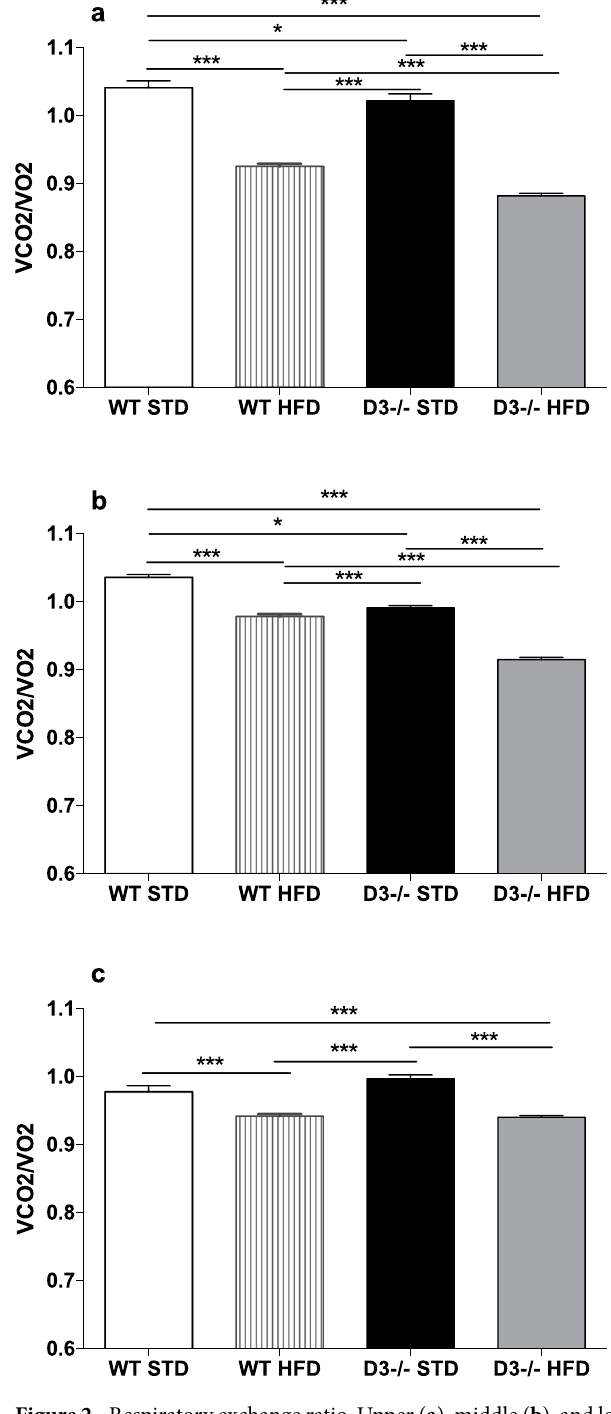
Figure 2. Respiratory exchange ratio. Upper ( a ), middle ( b ), and lower ( c ) panels are referring to juvenile (D3 − / − , n = 12; WT, n = 10), adult (D3 − / − , n = 11; WT, n = 7) and aged (D3 − / − , n = 8; WT, n = 9) mice, respectively. RER ( V CO 2 / V O 2 ) as the extent of lipid vs. carbohydrate oxidation in STD or HFD feeding conditions in D3 − / − and WT mice. Two-way ANOVA analysis of RER data showed significant main effects for groups and time in juvenile (groups: F 3,1880 = 544.2, p < 0.0001; time: F 46,1880 = 14.76, p < 0.0001), adult (groups: F 3,1440 = 143.1, p < 0.0001; time: F 47,1440 = 1.57, p < 0.01) and aged mice (groups: F 3,1410 = 41.31, p < 0.0001; time: F 46,1410 = 3.54, p < 0.0001). The analysis showed also significant groups x time interactions (F 138,1880 = 2.11, p < 0.0001; F 141,1440 = 1.37, p < 0.01; F 138,1410 = 2.04, p < 0.0001 as for juvenile, adult and aged mice, respectively). Post hoc tests for multiple comparisons data were performed by Bonferroni’s test. The bars above histograms depict the comparisons between genotypes and feeding conditions. Asterisks denote significance ( * p < 0.01; *** p < 0.0001). The error bars in histograms represent standard errors of the means